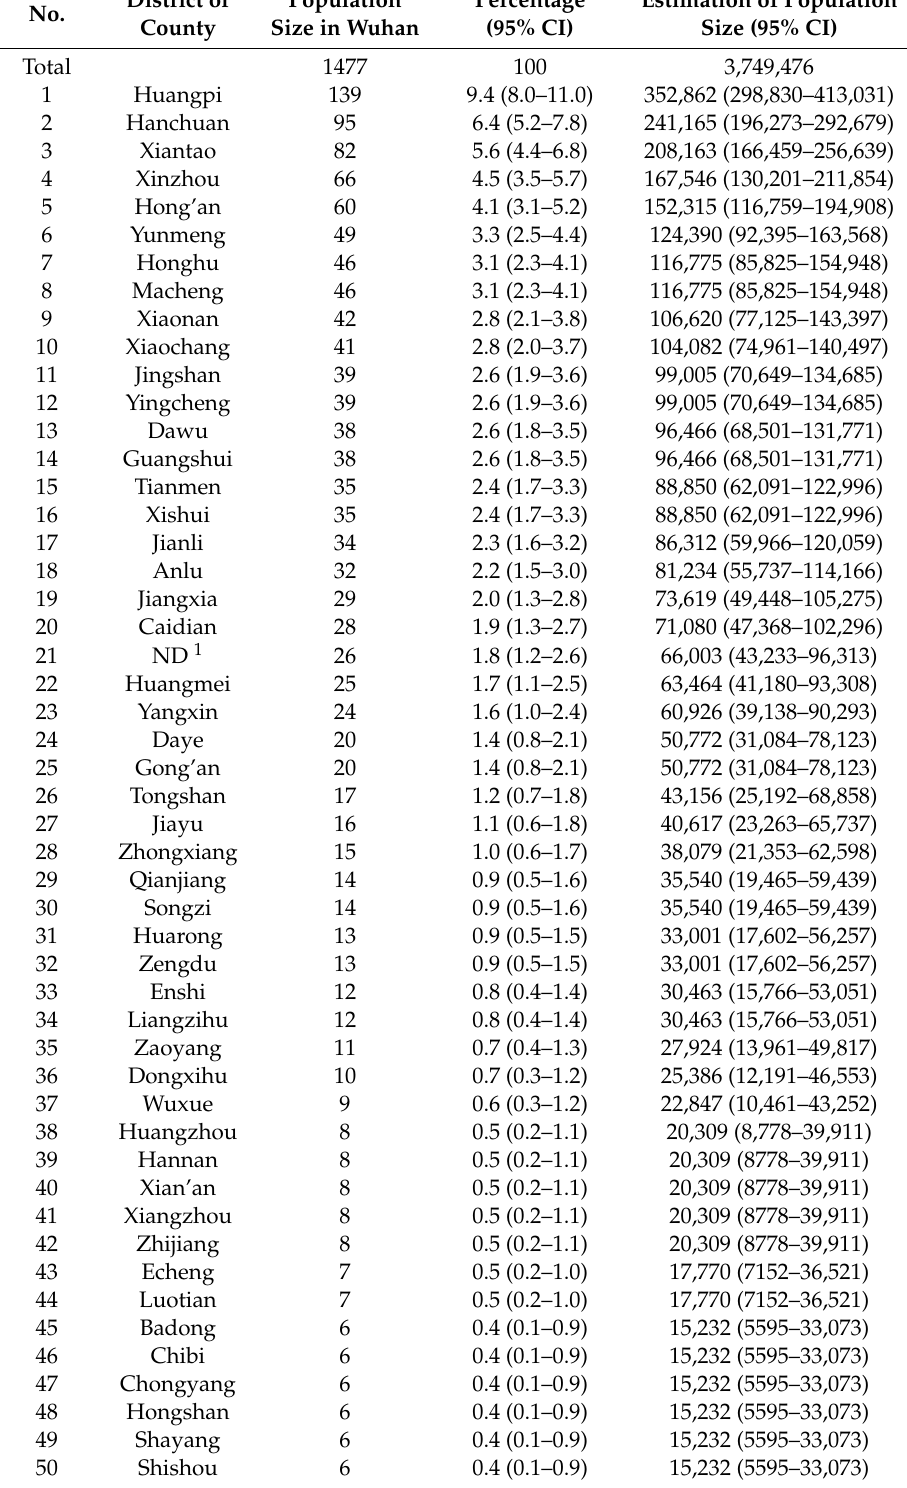
Table 7. Estimation of proportion and population size within Hubei Province based on floating population in Wuhan,